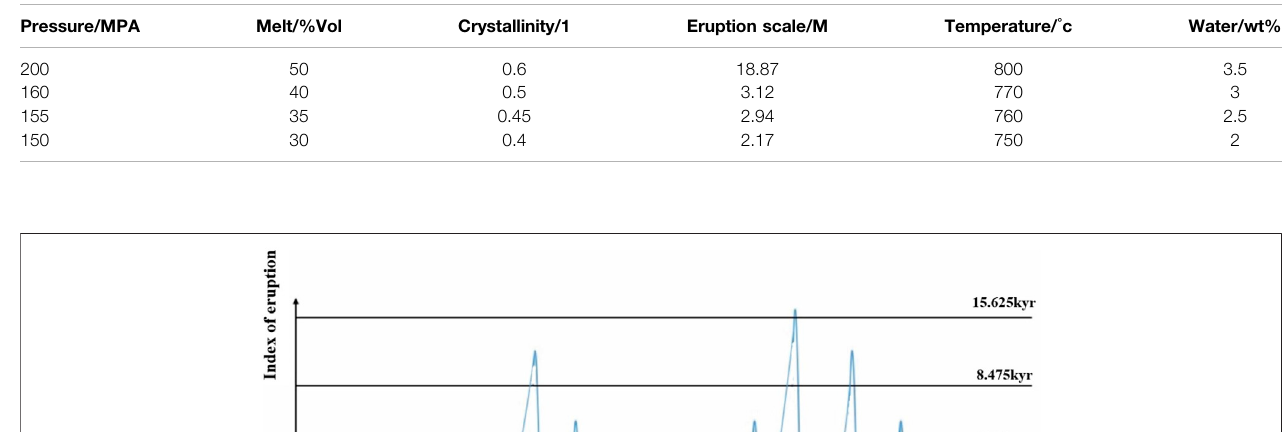
TABLE 1 | Comparison result of magma chamber parameters.